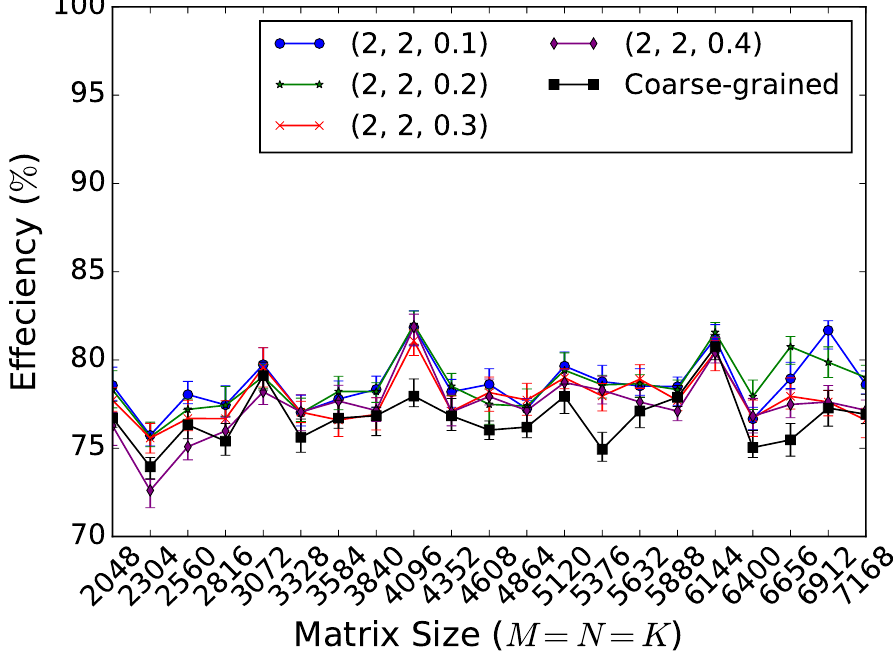
Figure 7. GEMM performance (64